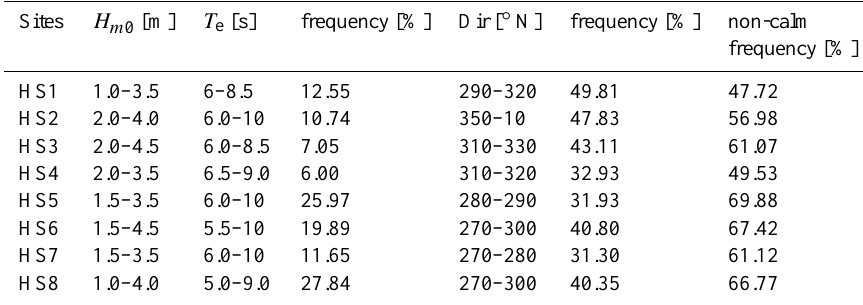
Table 4. Occurrence frequency of the most energetic T e − H m 0 and direction intervals. For each site the frequency of “non-calm” conditions are also reported.